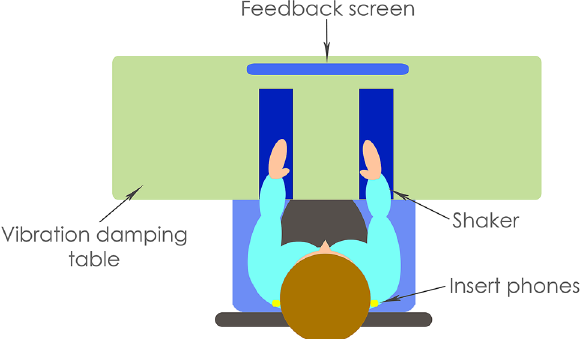
Figure 4. Schematic representation of the experimental set up (not to scale). This figure was generated using Photoshop CS6 (https ://www.adobe .com/uk/produ cts/photo